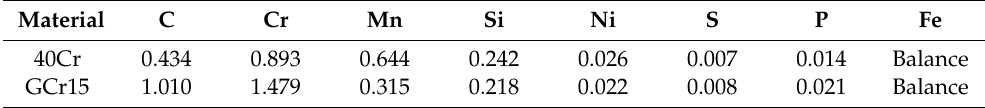
Table 1. Chemical compositions of 40Cr and GCr15 steels